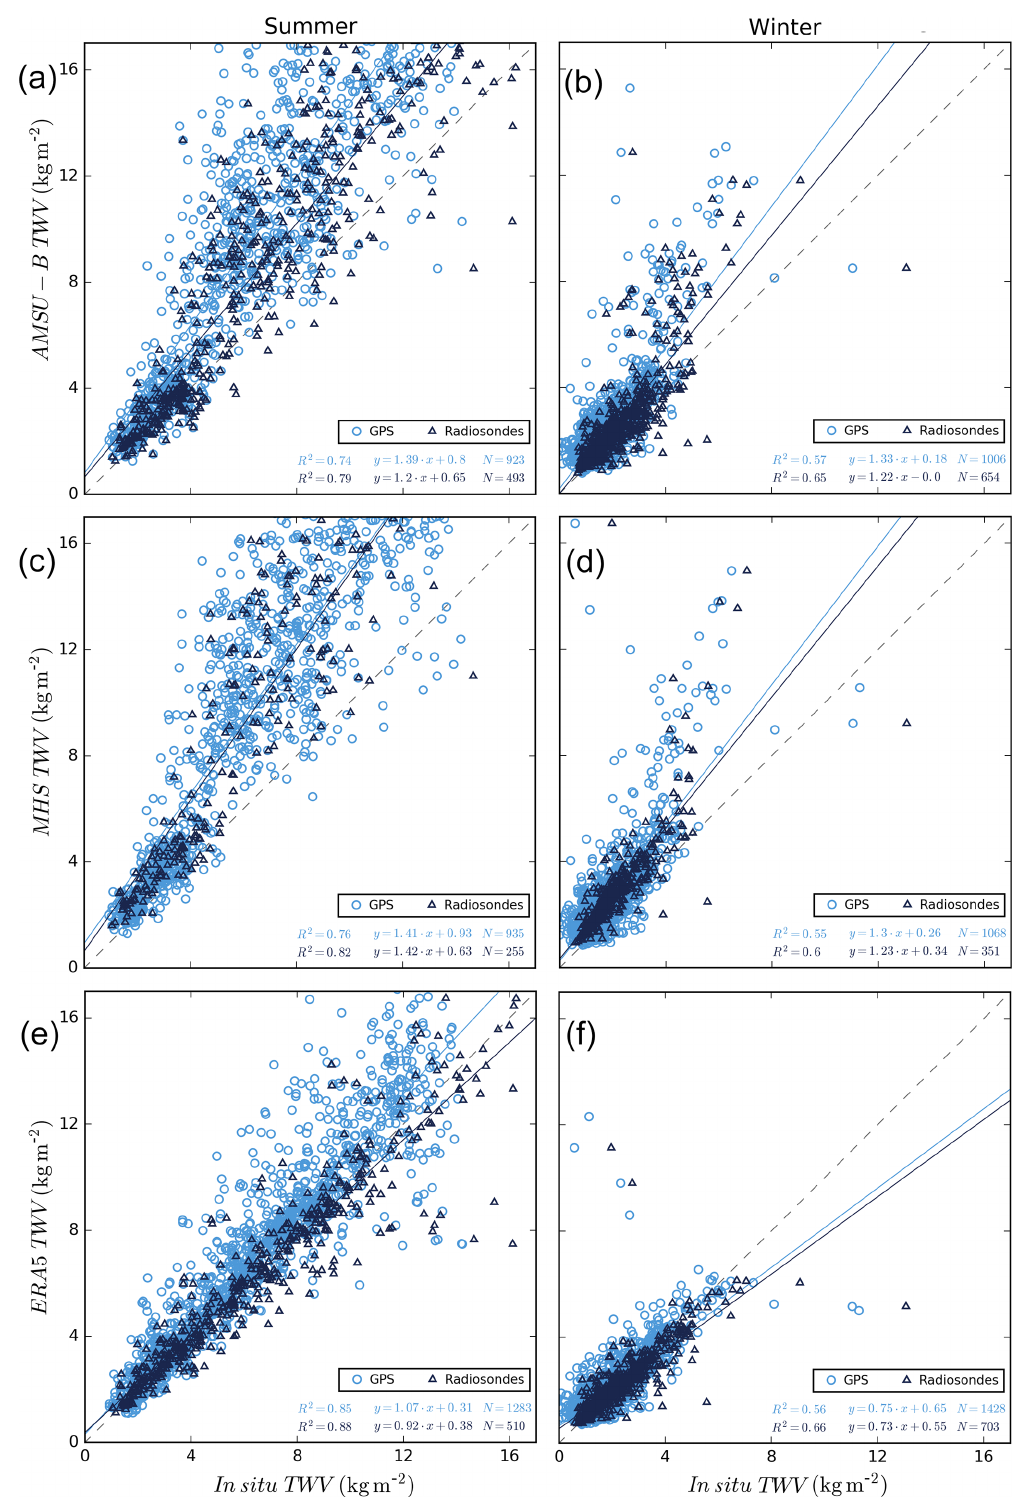
Figure 8. Scatter plots and fits for AMSU-B (a, b) , MHS (c, d) and ERA5 (e, f) TWV retrievals vs. GPS (light blue) and radiosonde (dark blue) TWV retrievals for all coincident points during summer (a, c, e) and winter (b, d, f) 2008 and 2009 at the Alert station. The solid lines in light and dark blue show the linear regressions for GPS and radiosondes in each case, while the dashed lines are the identity